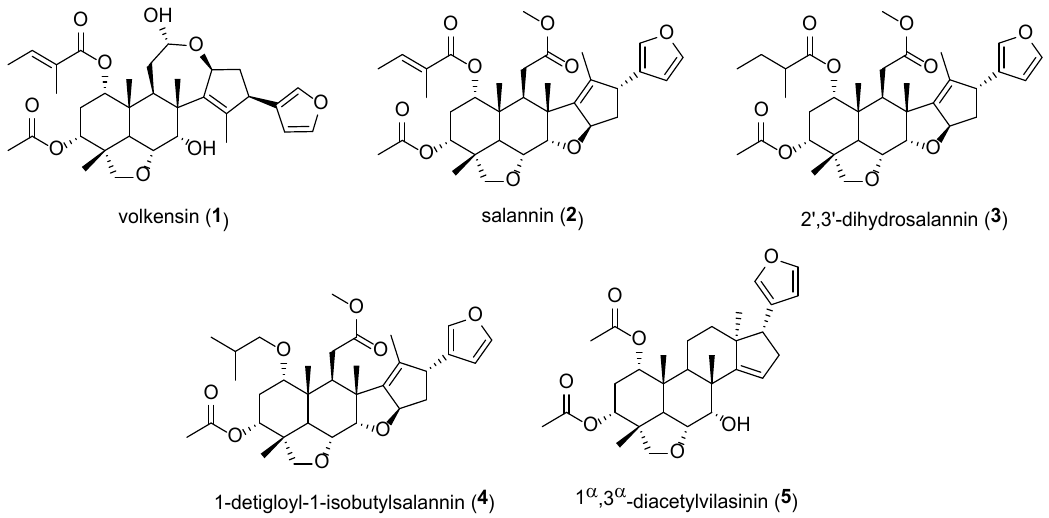
Figure 2. Chemical structures of compounds isolated from Melia volkensii with antifeedant and growth-inhibition activity against insects.